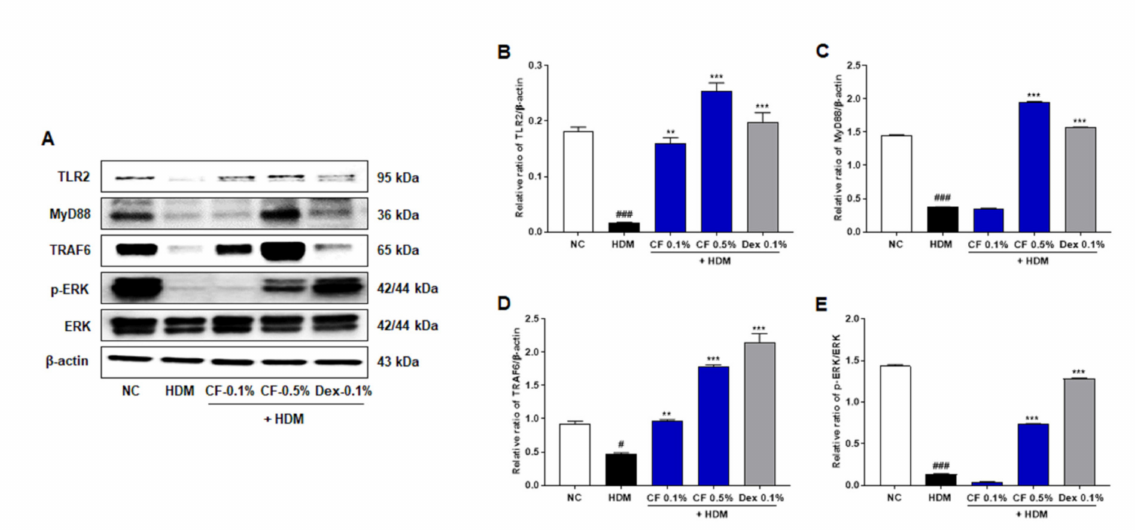
Figure 3. CF modulates TLR2/MyD88/TRAF6/ERK in the HDM-induced AD mouse model. ( A ) TLR2, MyD88, TRAF6, p-ERK were analyzed in dorsal skin tissue by western blotting. Bar graphs present the relative expression of ( B ) TLR2, ( C ) MyD88, and ( D ) TRAF6, and ( E ) p-ERK. Relative expression levels of TLR2, MyD88, and TRAF6 were obtained by normalization against β -actin. Relative expression levels of p-ERK were obtained by normalization against ERK. All data are represented per group, as means ± SEM (n = 6 mice per group). Differences were evaluated by one-way ANOVA, with Dunnett’s post-hoc tests; # p < 0.05 and ### p < 0.001 compared with the NC group; ** p < 0.01 and *** p < 0.001 compared with the HDM